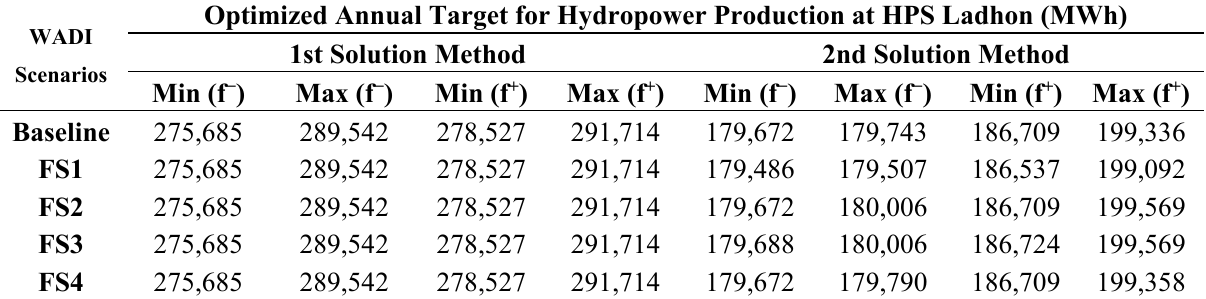
Table 18. Optimized annual target for hydropower production at HPS Ladhon (MWh).